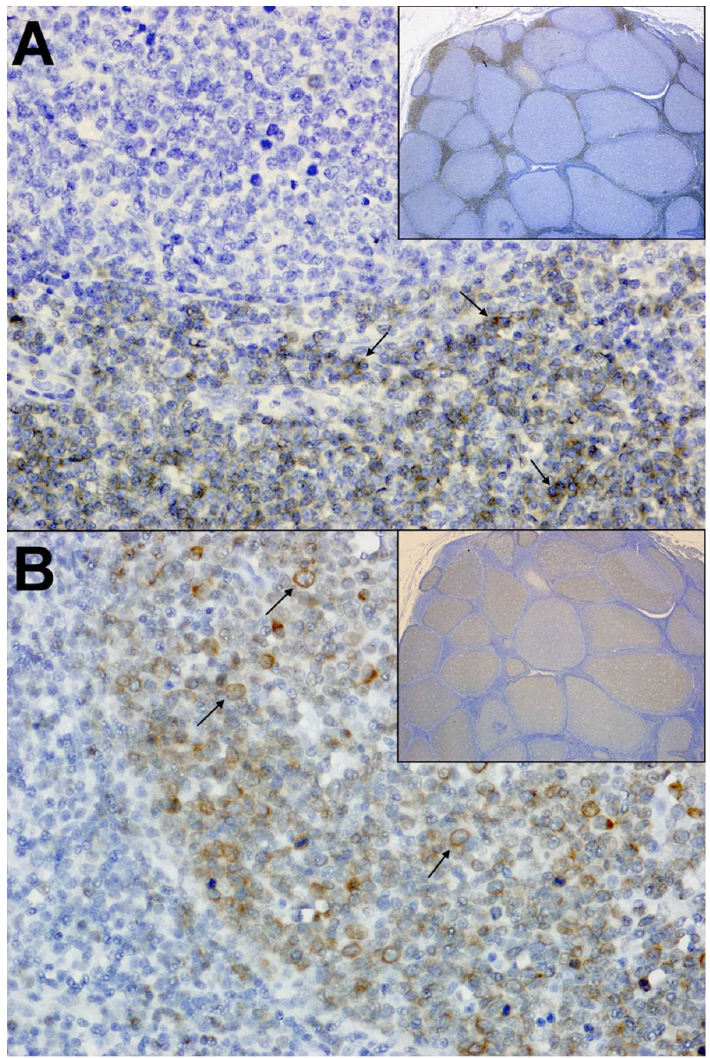
Figure 1. Immunohistochemistry from a feline immunodeficiency virus (FIV)-infected cat with primary B cell lymphoma. ( A ) Mesenteric lymph Node; 40× and 4× (inset). Normal amounts of interlobular T lymphocytes (arrows) are present throughout the lymph node. Anti-CD3 (IHC) with DAB as chromogen and hematoxylin counterstain. ( B ) Mesenteric lymph Node; 40× and 4× (inset). Neoplastic B lymphocytes (arrows) multifocally expand the normal lymph node architecture. Anti-CD79a IHC with DAB as chromogen and hematoxylin counterstain.